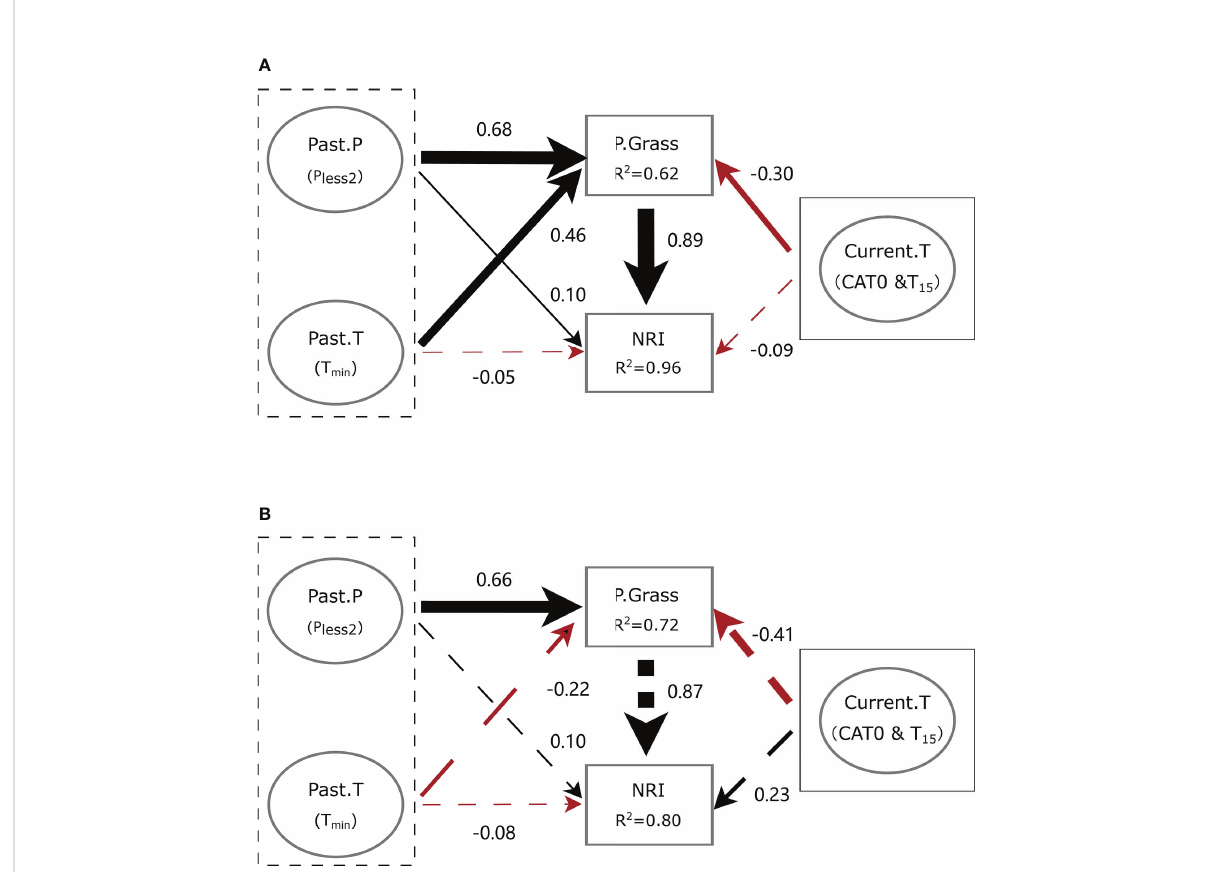
FIGURE 8 Simpli fi ed diagram of the structural equation model (SEM) showing the interplay between meteorological conditions and community phylogenetic structure at (A) the Inner Mongolia Grassland Ecosystem Research Station (ERS) and (B) Xilinhot National Climate Observatory (NCO) in Inner Mongolia, China. Black dotted boxes denote meteorological conditions before the growing season, and solid boxes denote meteorological conditions of the current growing season. Past.P indicates a precipitation factor before the growing season (i.e., precipitation of the years with less precipitation in the past 2 years, P less2 ). Past.T indicates a temperature factor before the growing season (i.e., extremely low temperature in January, T min ). Current.T indicates meteorological factors of the current growing season, including accumulated temperature >0°C (CAT0) and average temperature of the last 15 days before sampling ( T 15 ). P.Grass, proportion of perennial grass biomass in a quadrat. NRI, net relatedness index. Numbers near the pathway arrows are the standard path coef fi cients. Black and red arrows represent positive and negative pathways, respectively. Dashed arrows indicate non-signi fi cant relationships ( p > 0.05). Arrow width represents the strength of the